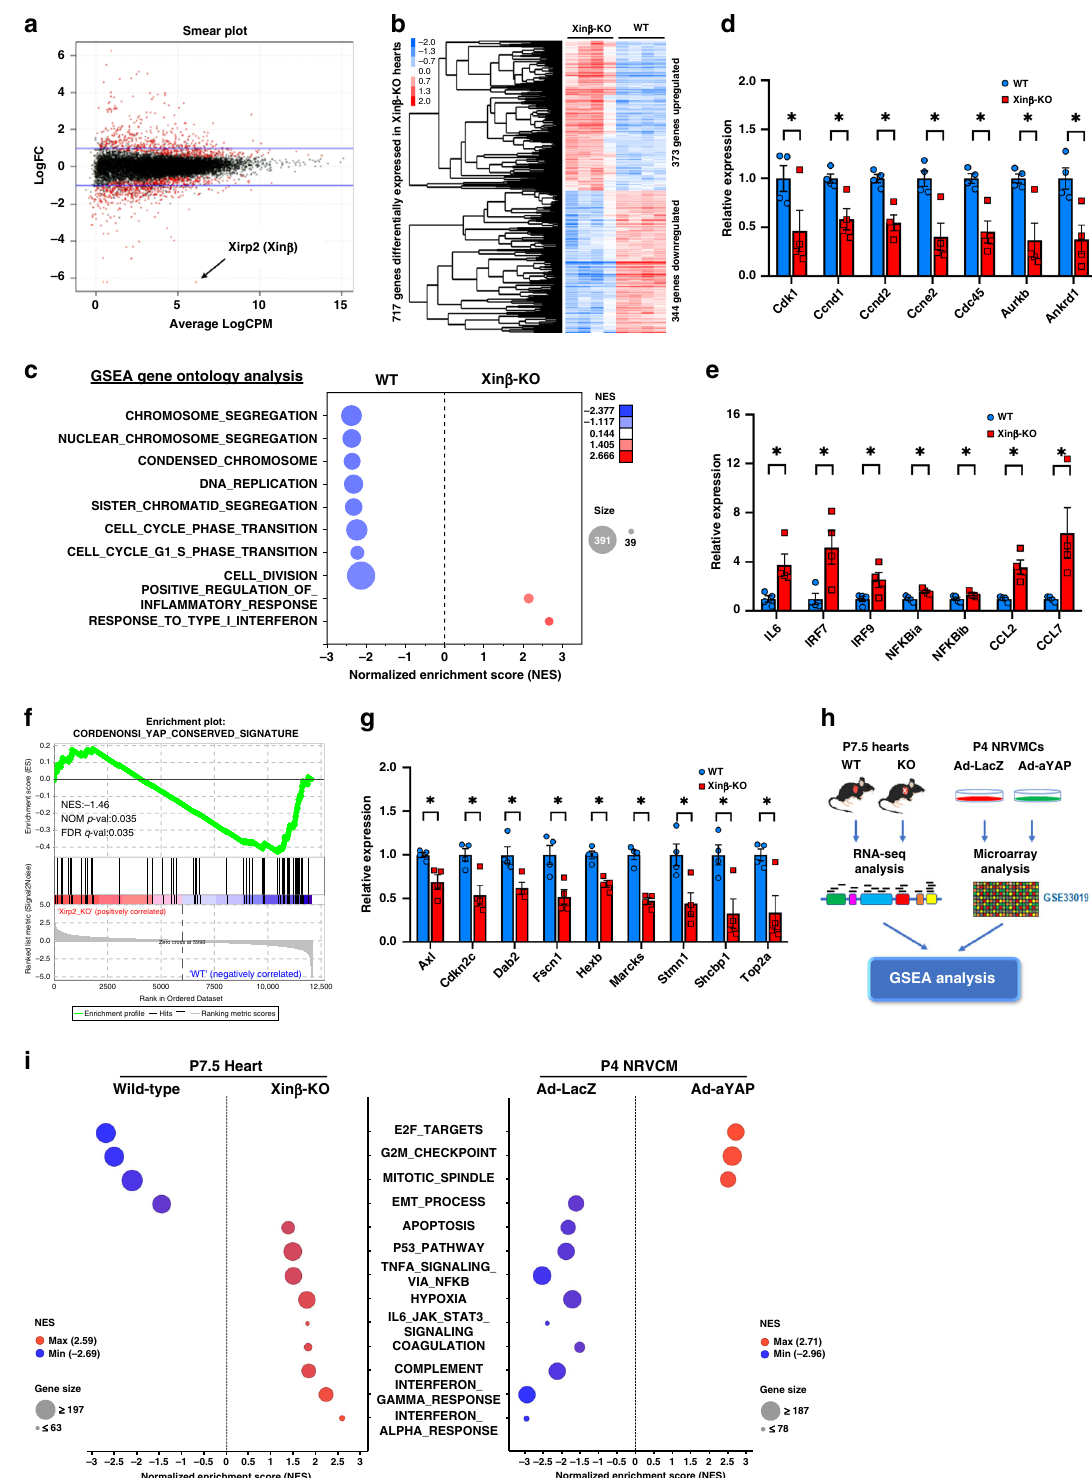
expression in mouse hearts after AAV- Xin β sgRNA injection (Supplementary Fig. 3c). Immunostaining indicated that Xin β was not detected in GFP-positive cardiomyocytes (Supplementary Fig. 3d). Unlike global Xin β KO mice, which all died prior to weaning, AAV- Xin β sgRNA -injected mice lived to adulthood (Supplementary Fig. 3e). Echocardiography showed that AAV- Xin β sgRNA -treated mice had modestly reduced cardiac function at 1 – 6 months of age (Fig. 2f and Supplementary Fig. 3f).